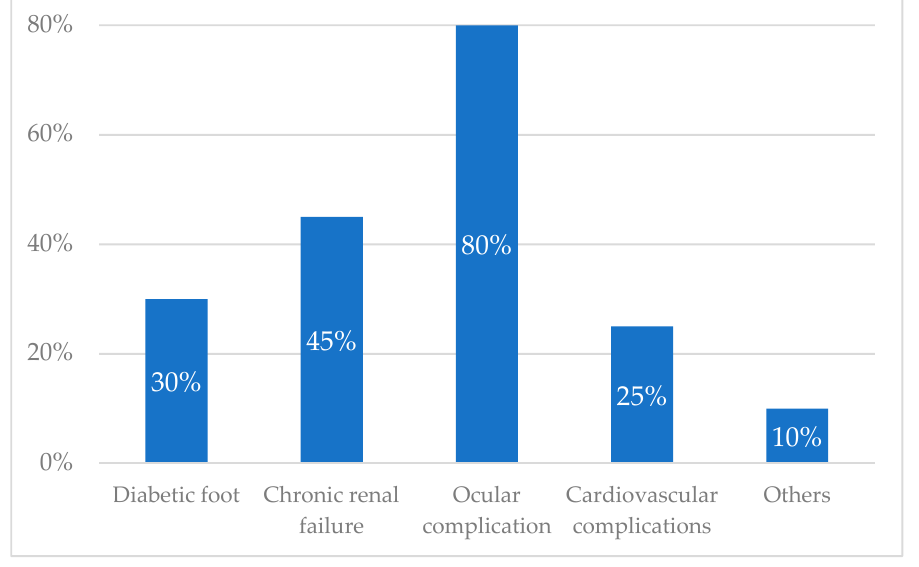
Figure 4. Knowledge of the complications of diabetes.